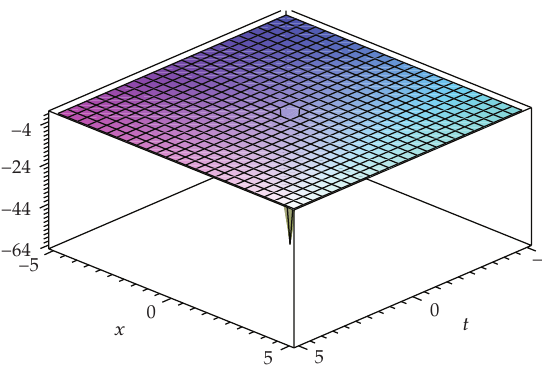
Figure 1: (cid:3) α (cid:9) β (cid:9) ν (cid:9) λ (cid:9) 1 (cid:4)